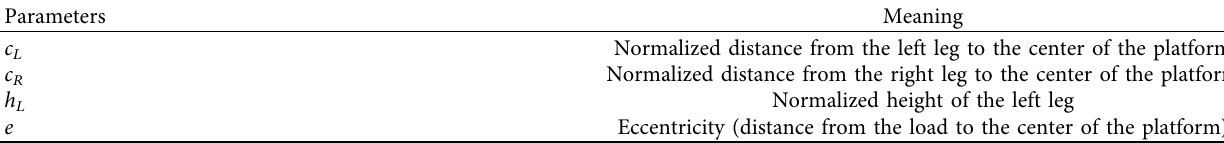
Table 1: Variables considered in the FE studies.